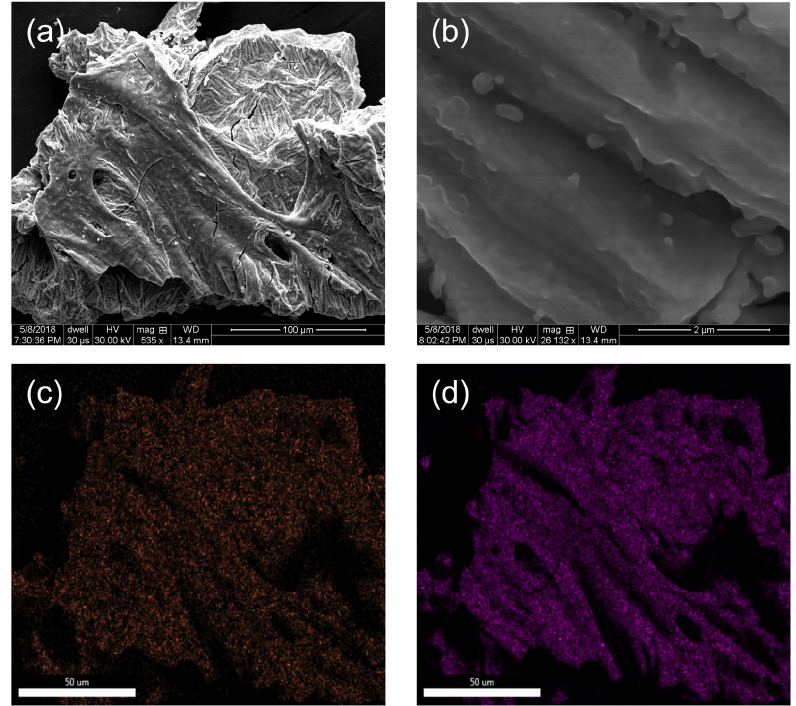
Figure 7. SEM images ( a , b ) of the product from thermolysis of 1 at 900 °C under an atmosphere of 5% H 2 (Ar balance), along with the ( c ) Fe and ( d ) Mo EDX maps associated with the SEM image ( a ). Scale bar: ( a ) 100 μm, ( b ) 2 μm, and ( c , d ) 50 μm.